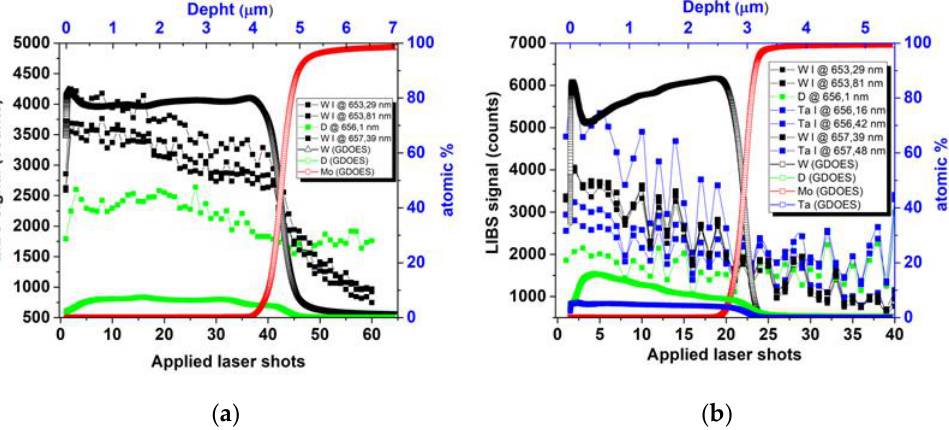
Figure 3. ( a ) Comparison of the LIBS intensities (filled squares) and GDOES profiles (open squares) of the W80/N14/D6 sample and ( b ) the W75/Ta4.5/D10 sample. The vertical yellow lines mark the nominal thickness of the superficial layer to the substrate.